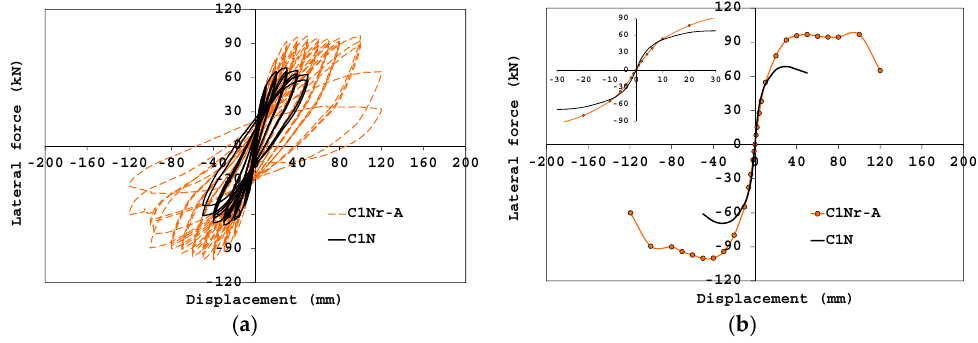
Figure 13. F ‒Δ hysteresis curves ( a ) and envelopes ( b ): columns C1N and C1Nr-A.